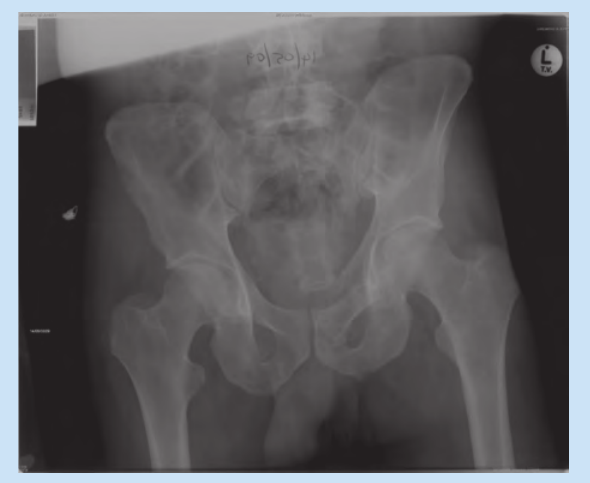
Fig. 2. X-ray of April 2009 shows no foreign body in the pelvis.